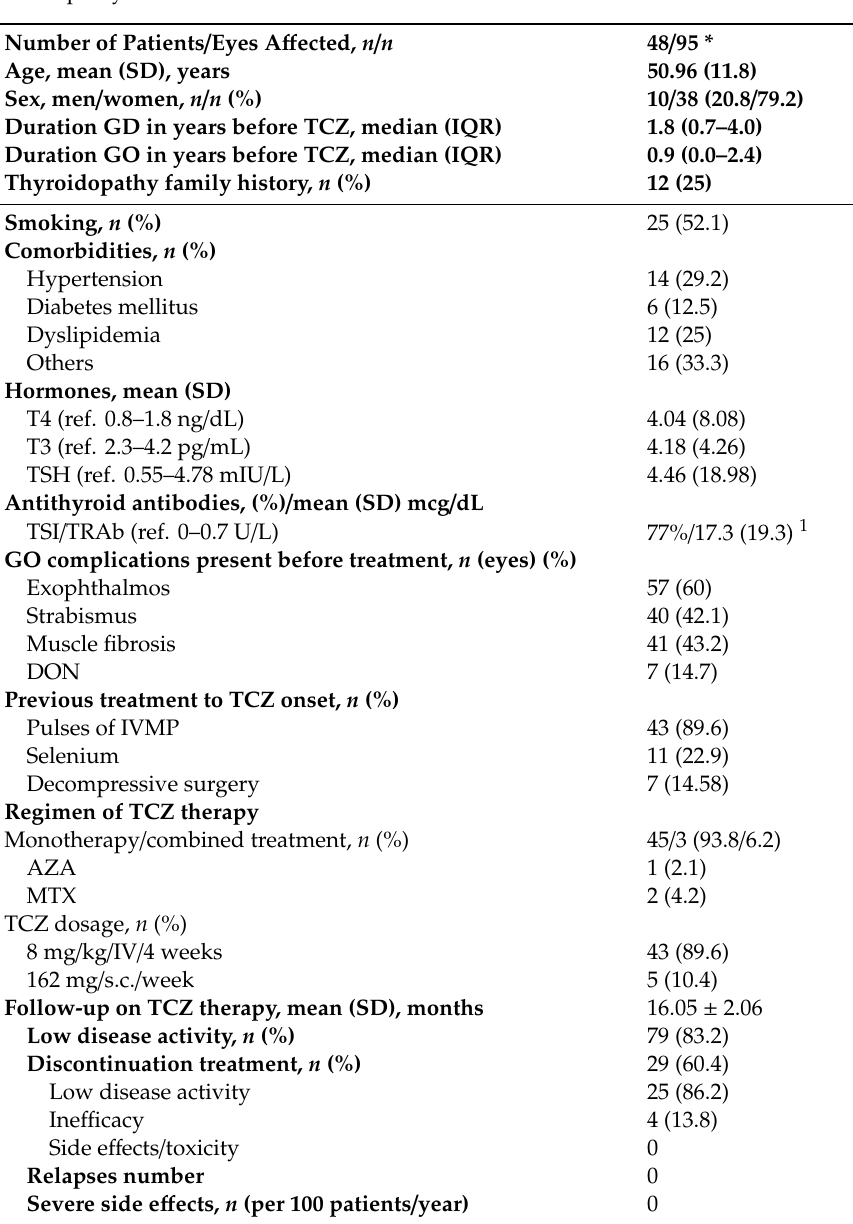
Table 1. General features and long-term follow-up of a series of 48 patients with glucocorticoid-resistant Graves’ orbitopathy treated with